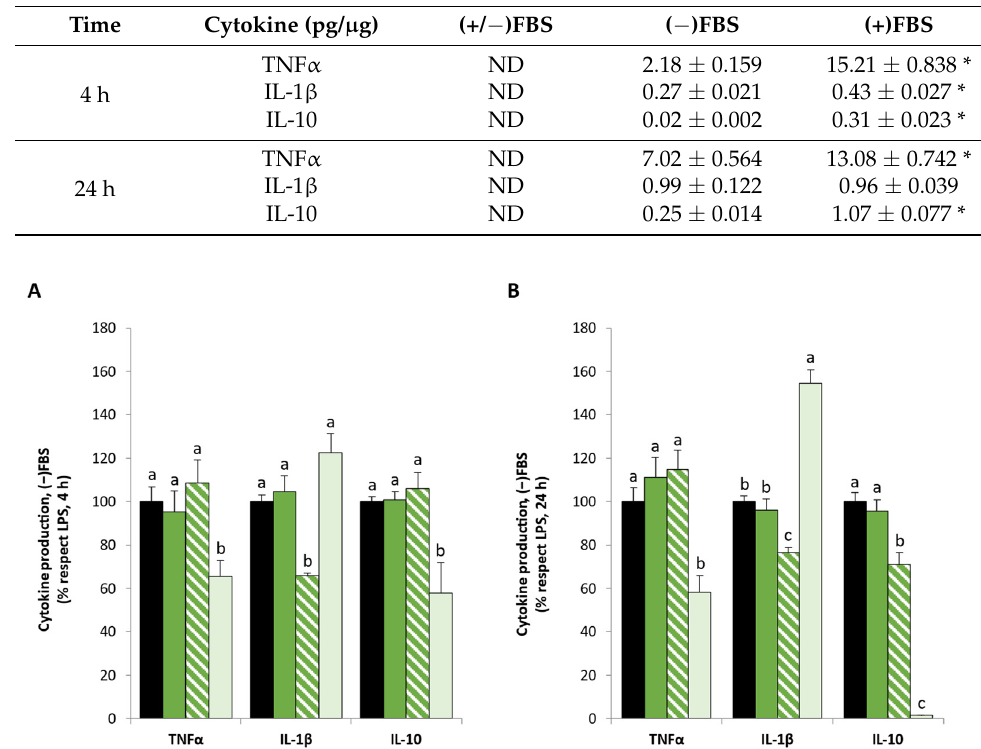
Figure 8. Cytokine production (TNF α , IL-1 β , and IL-10) in macrophages maintained in ( − )FBS or (+)FBS for 24 h ( A – D , respectively), supplemented for 24 h with 12.5 and 625 μ M OH-SeMet or 10 mM NAC and then stimulated with LPS (100 and 250 ng/mL) for 4 or 24 h ( A – D , respectively). The results are expressed as mean ± SEM of n = 9 cultures. Different letters denote significant differences ( p < 0.05) between conditions for each cytokine. Finally, the effect of OH-SeMet supplementation (625 μ M) on the phagocytic and killing capacities of LPS-stimulated macrophages in the presence of FBS was studied after incubation with Salmonella Enteritidis (Figure 9). LPS stimulation reduced the number of CFU of Salmonella Enteritidis from samples of both extracellular and intracellular com- partments. OH-SeMet supplementation accentuated this effect, suggesting an increase in the phagocytic and killing capacities. Meanwhile, NAC only decreased the CFU of